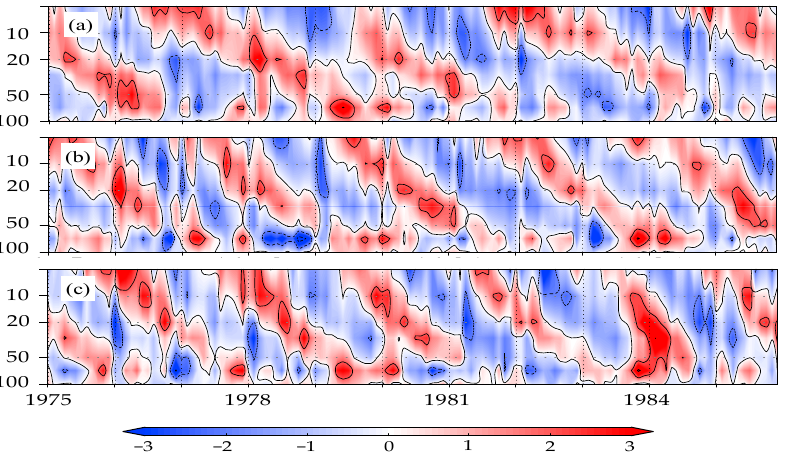
Figure 3. Time–height cross-sections of zonal–mean temperature anomalies (K) averaged between 10° S and 10° N in the tropical stratosphere for the ( a ) P, ( b ) ST, and ( c ) N runs from 1975 to 1985. Contours interval is 2 K.